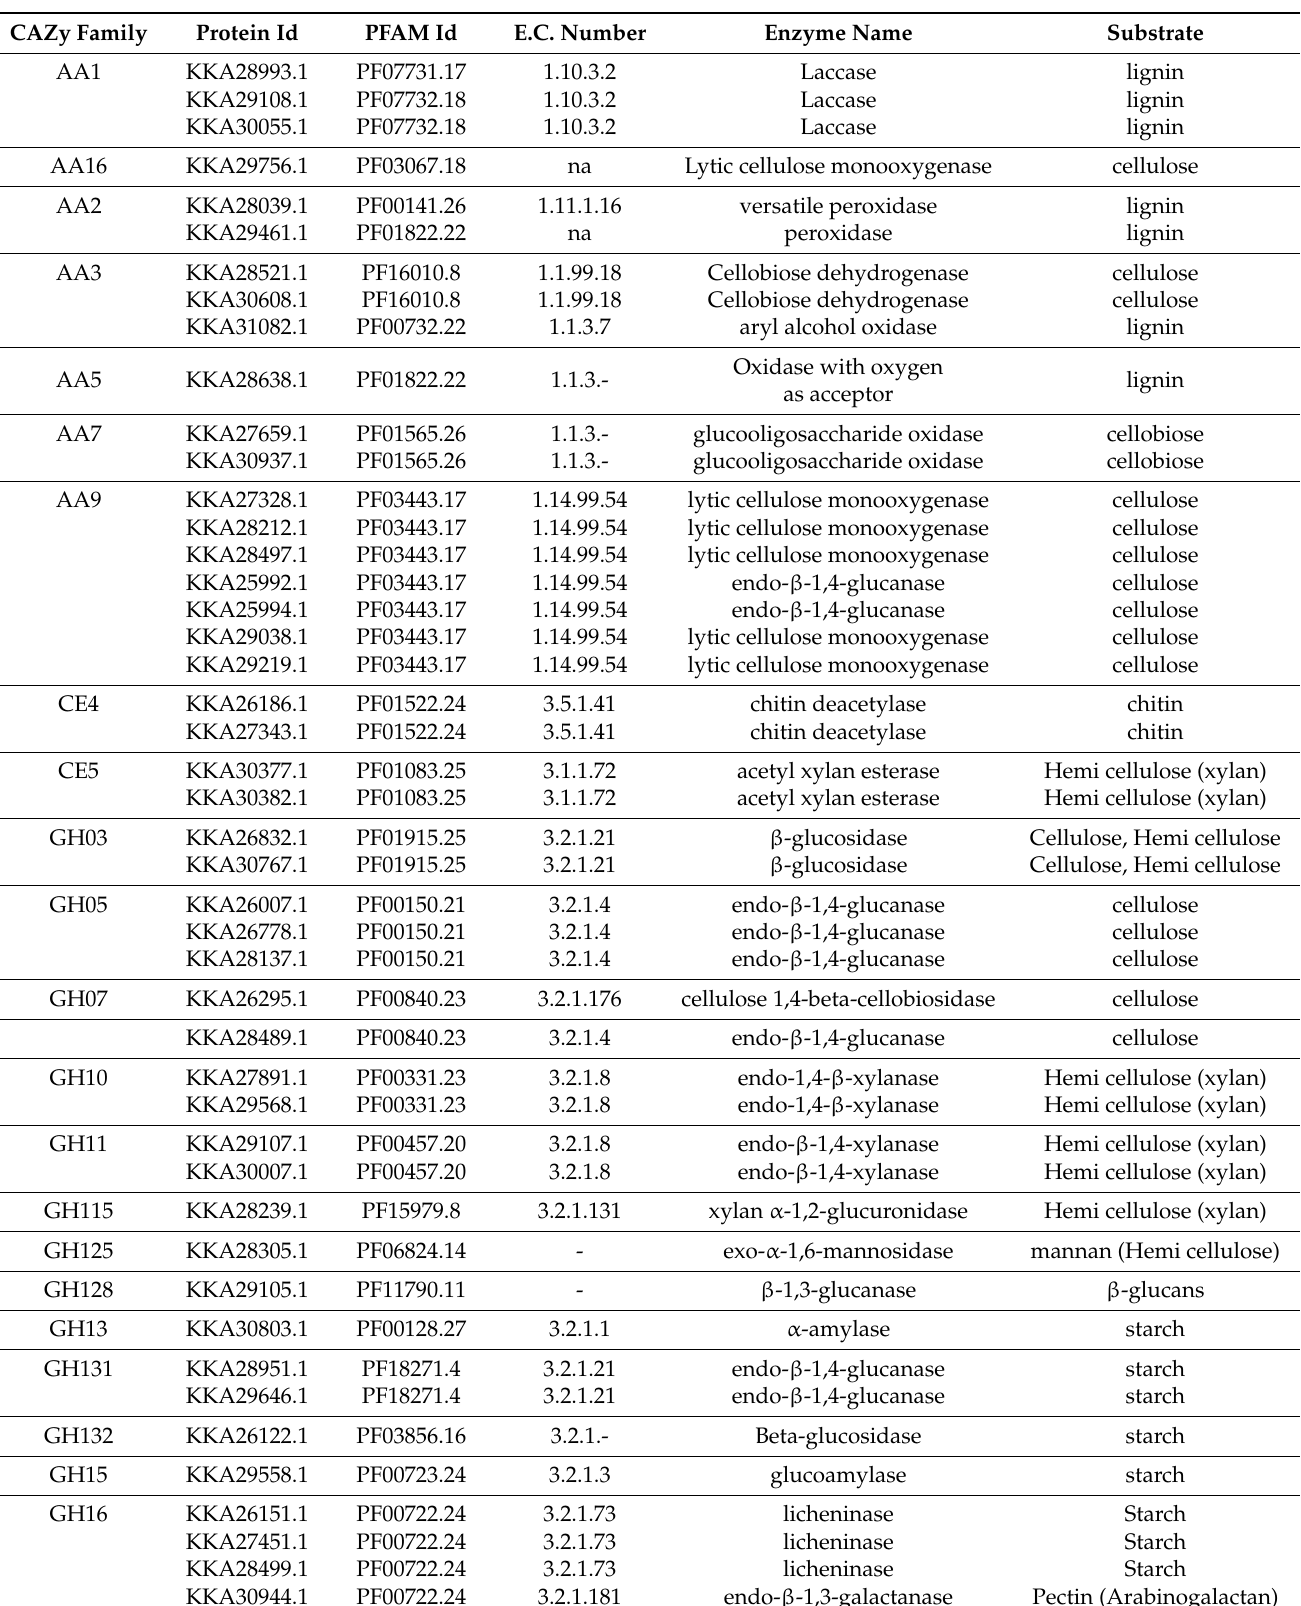
Table 2. List of CAZymes in the secretome T. punctulata